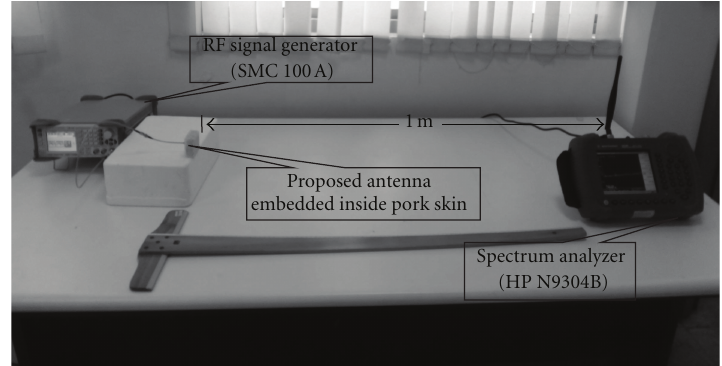
Figure 7: Measurement of received power at 1m away from the proposed implanted antennas (delivered power is 1mW).